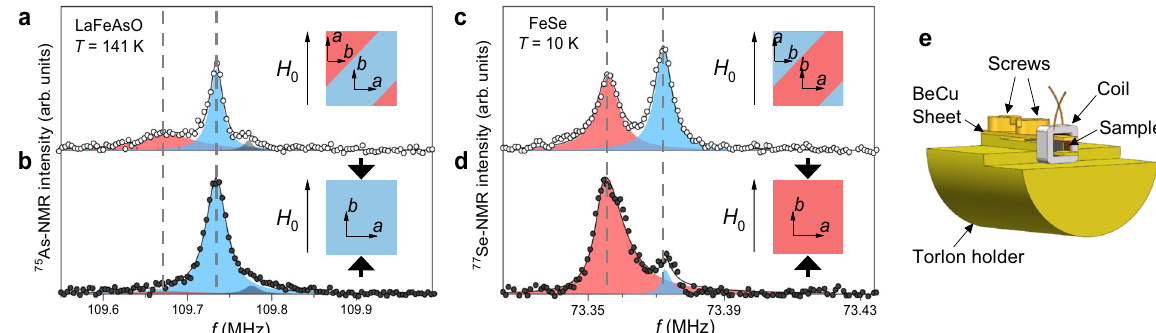
Fig. 1 NMR evidence for sample detwinning under uniaxial stress. a , b 75 As-NMR central line in LaFeAsO with ( b ) and without ( a ) uniaxial stress at T = 141 K and H 0 = 15 T. Upon application of stress, the integrated intensity of the higher-frequency peak increases at the expense of the low-frequency peak. c , d 77 Se-NMR spectra of FeSe with ( d ) and without ( c ) stress at T = 10 K and H 0 = 9 T, respectively. At variance with LaFeAsO, the remaining intensity of the second peak in FeSe indicates that the crystal is not fully detwinned. This is because the maximum stress applicable on FeSe crystals is about half of that for LaFeAsO. FeSe distorts and exfoliates above ~5 MPa, while LaFeAsO does not break up to at least 15 MPa. This thus limits the maximal stress that can be applied on FeSe and explains that we could not fully detwin it. LaFeAsO spectra are fi tted by three Lorentzian functions (the small peak at ~109.77 MHz is present at any temperature and is attributed to an impurity — see Supplementary Fig. 6). FeSe spectra are fi tted by two Lorentzian functions. The 1:1 area ratio of the peaks in a , c shows that the twin domains are equally populated in the unstrained samples. The different widths for the two peaks are consistent with other reports (e.g., ref. 61 ) but not presently understood. Notice that the quadrupolar interaction contributes to the peak splitting in LaFeAsO. As explained in Supplementary Note 2, this effect has been taken into account for extracting the Knight-shift anisotropy in Fig. 2. e Schematic drawing of the uniaxial stress device with the NMR coil.